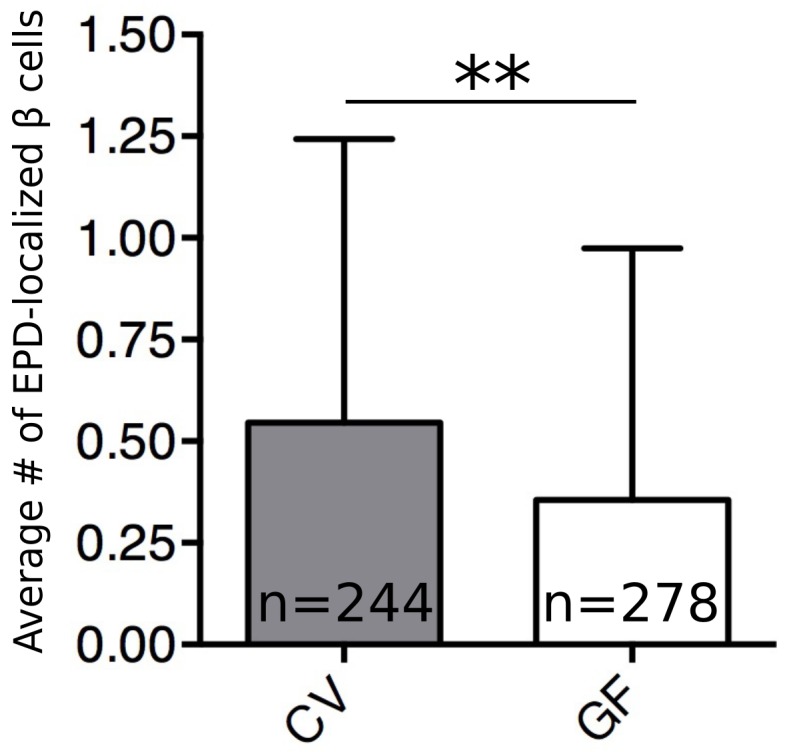
The microbiota increase β cell neogenesis from the EPD.Quantification of EDP localized insulin expressing cells per animal in 6 dpf CV and GF larvae.Error bars represent the standard deviation. **t520=3.28, p=0.0011.